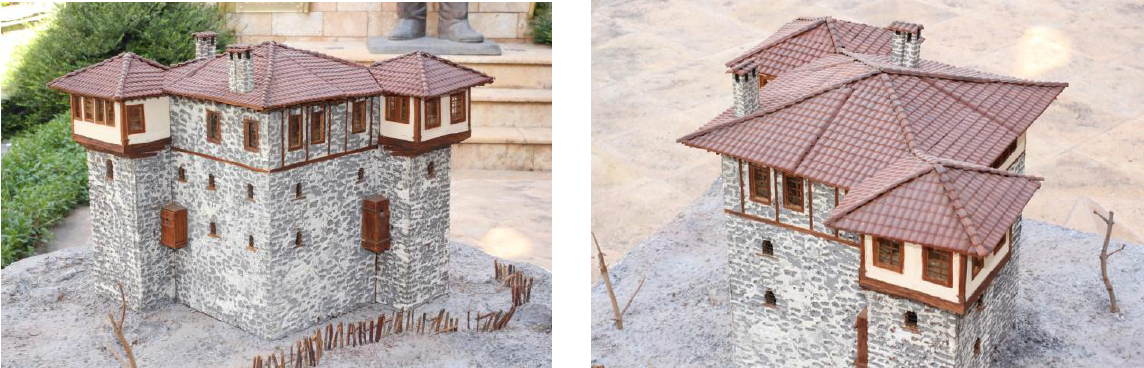
Figure 5: The model-maquette displayed in Folklore Museum of the Municipality of Kozani,